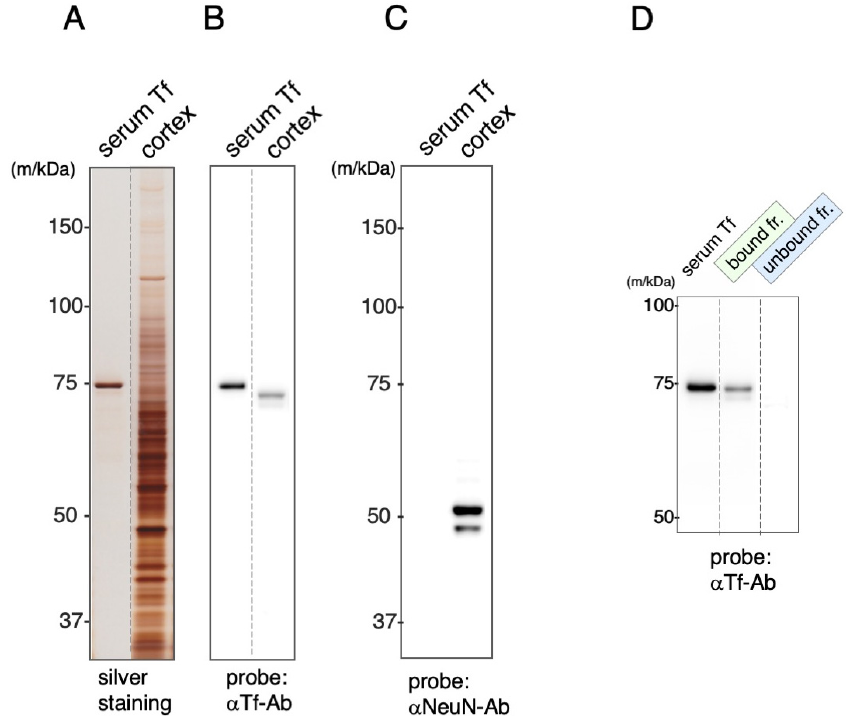
Figure 6. SDS ‐ PAGE and immunoblotting of human brain extracts. Brain extracts were subjected to to SDS-PAGE ( A ) followed by immunoblotting using anti-Tf antibody ( α Tf-Ab) ( B ). Another blot SDS ‐ PAGE ( A ) followed by immunoblotting using anti ‐ Tf antibody ( α Tf ‐ Ab) ( B ). Another blot was probed with anti ‐ NeuN antibody ( α NeuN ‐ Ab) ( C ). The extracts were separated into bound and was probed with anti-NeuN antibody ( α NeuN-Ab) ( C ). The extracts were separated into bound and unbound fractions by Tf antibody ‐ immobilized beads and subjected to immunoblotting ( D ). Each unbound fractions by Tf antibody-immobilized beads and subjected to immunoblotting ( D ). Each lane separated on the gel is indicated by dotted lines. lane separated on the gel is indicated by dotted lines.